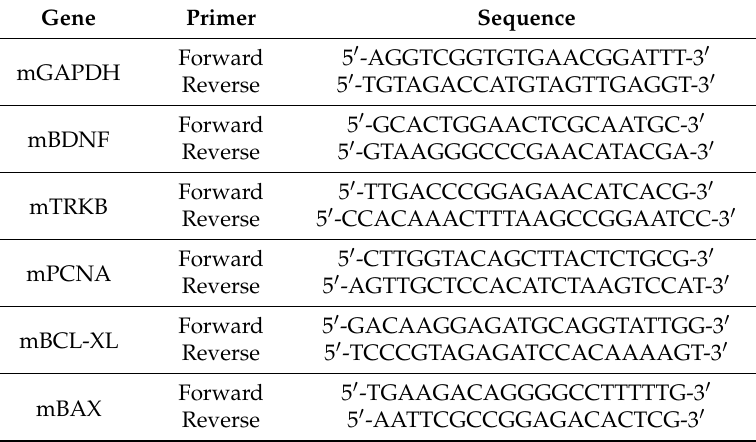
Table 2. List of oligonucleotide sequences used in the